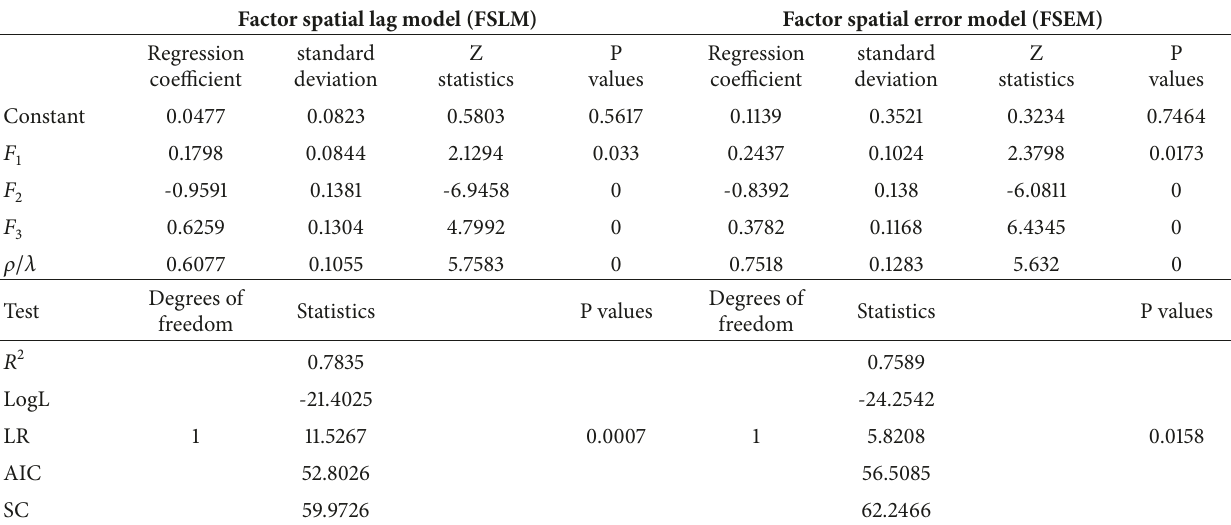
Table 7: FSLM and FSEM of maximum likelihood (ML) estimation. Factor spatial lag model